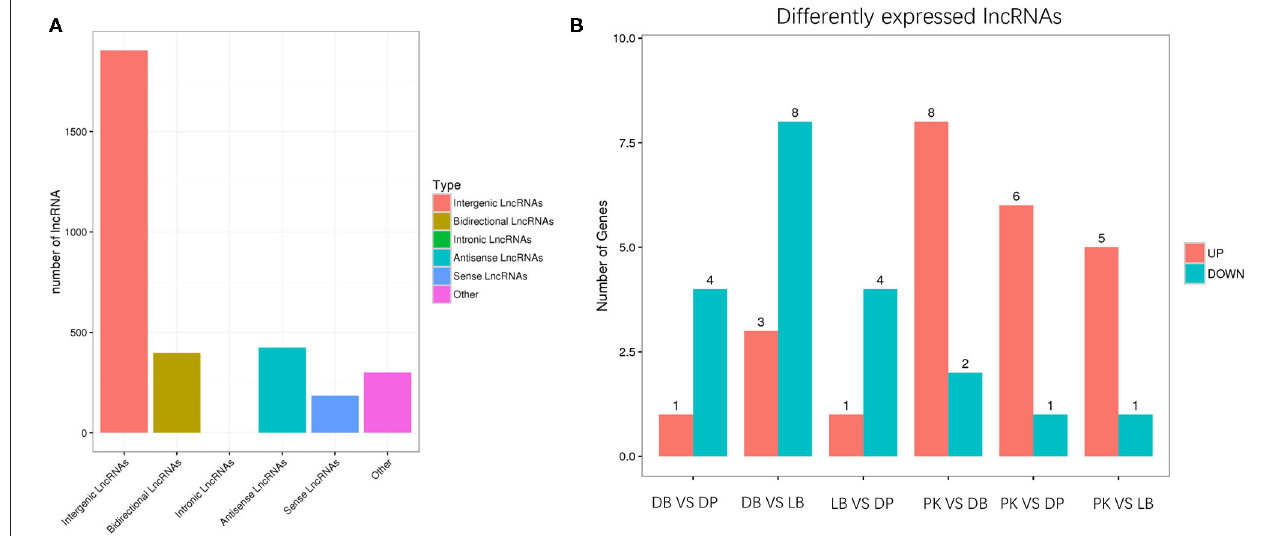
FIGURE 2 | (A) represents lncRNAs including intergenic lncRNAs, bidirectional lncRNAs, antisense lncRNAs, sense lncRNAs, and other lncRNAs. (B) represents differently expressed lncRNAs between comparisons. DB, DP, LB, and PK mean chickens producing dark blue, dark brown and greenish, light blue, and pink eggshell eggs,